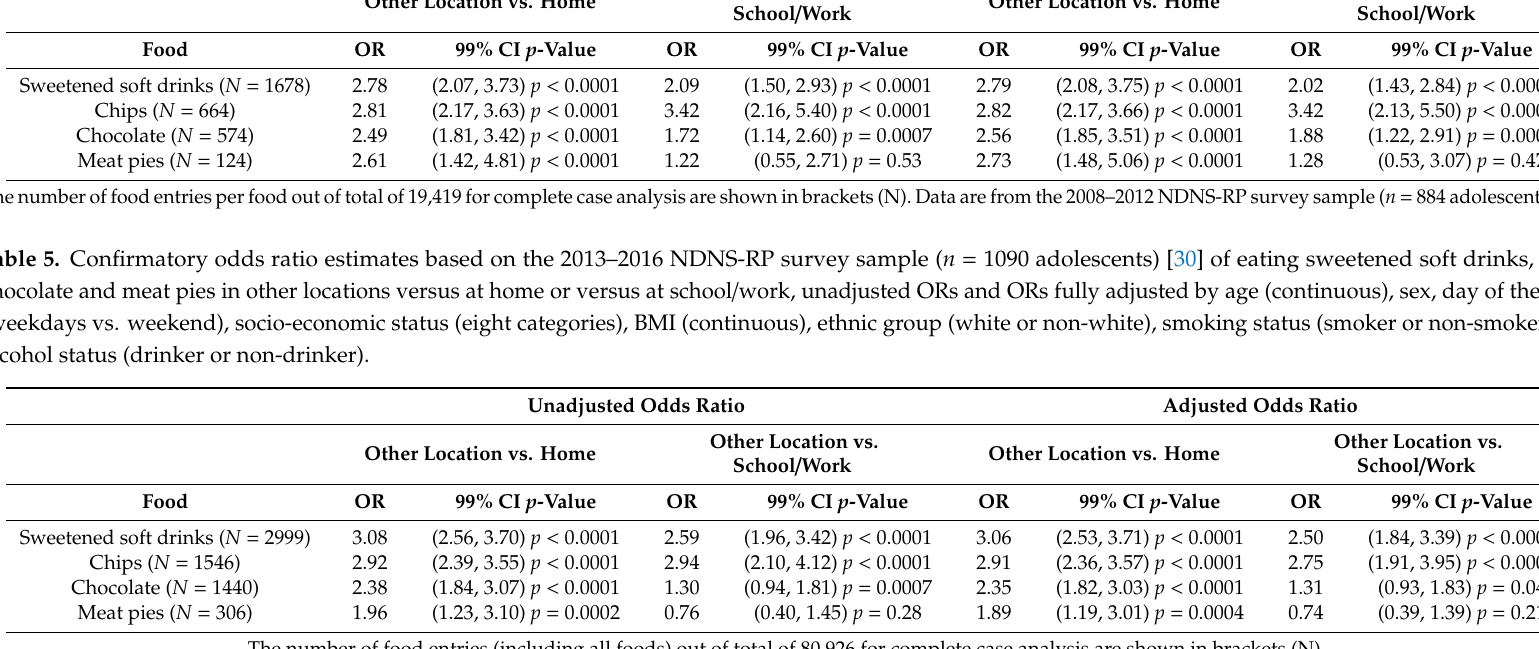
Table 4. Odds ratio estimates of eating sweetened soft drinks, chips, chocolate and meat pies in other locations versus at home or versus at school / work, unadjusted and adjusted by age (continuous), sex, day of the week (weekdays vs. weekend), socio-economic status (eight categories), BMI (continuous), ethnic group (white or non-white), smoking status (smoker or non-smoker) and alcohol status (drinker or non-drinker). Unadjusted Odds Ratio Adjusted Odds Ratio Other Location vs. Other Location vs. Other Location vs. Home Other Location vs. Home School / Work School / Work